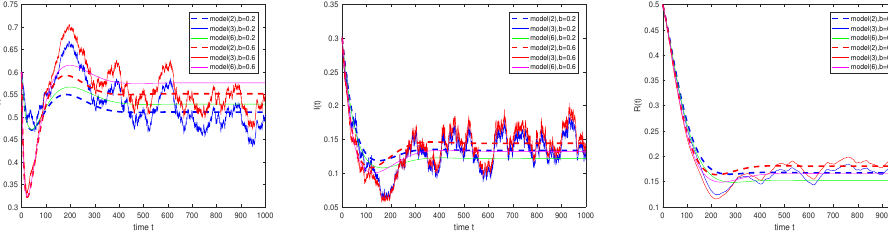
Figure 2. The paths of S ( t ) , I ( t ) , and R ( t ) under the environmental capacity K = 0.9,1.1.